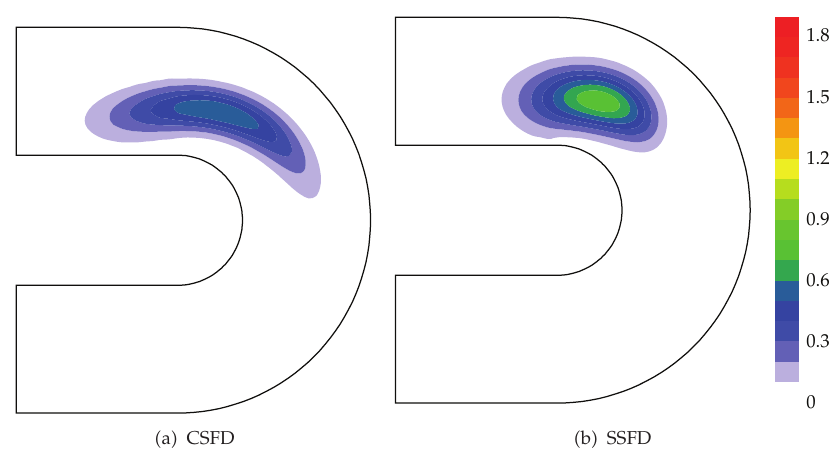
Figure 10: Concentration distribution in Rozovski’s channel at t (cid:9)